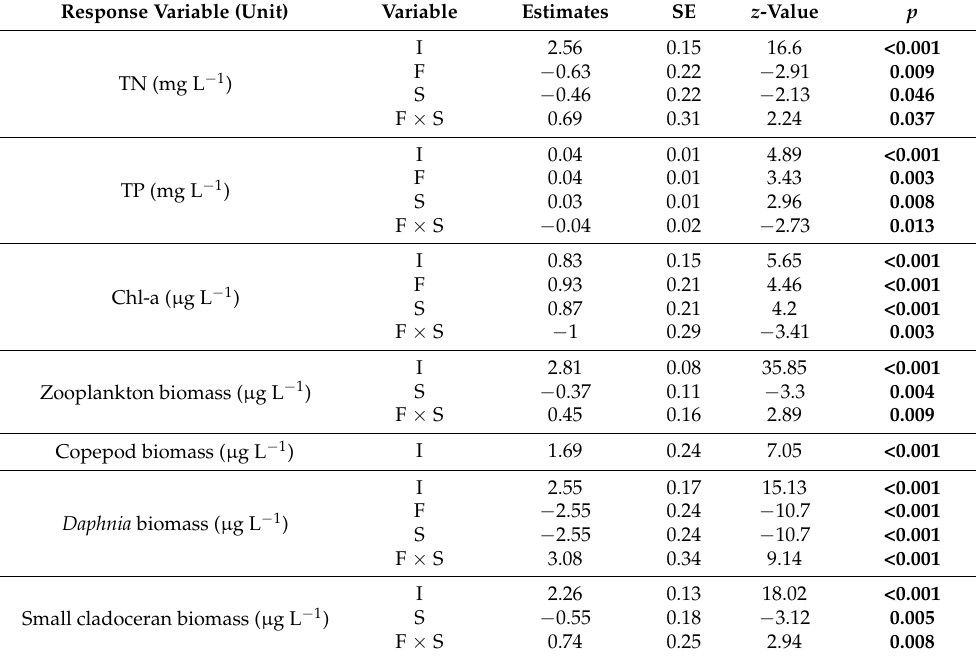
Figure 1. Differences in environmental indicators among treatments. ( a ) Total nitrogen (TN), ( b ) Dissolved total nitrogen (DTN), ( c ) Total phosphorus (TP), ( d ) Dissolved total phosphorous (DTP). C: Control, F: Fish-added treatment, S: Shrimp-added treatment, FS: Fish–shrimp-added treatment; each treatment was replicated six times. Different letters above the same environmental indicator bar indicate statistically significant differences according to the results of one-way ANOVA. Table 1. Generalized linear mixed model analysis of di ff erent treatments on the investigated factors.